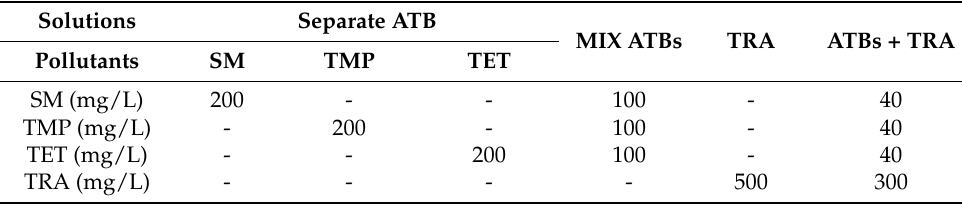
Table 1. Summary of the prepared solution for membrane tests.